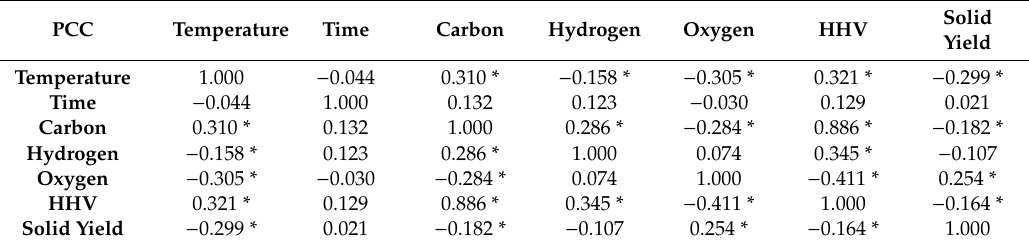
Table 4. Pearson correlation matrix between hydrochar properties (CI =